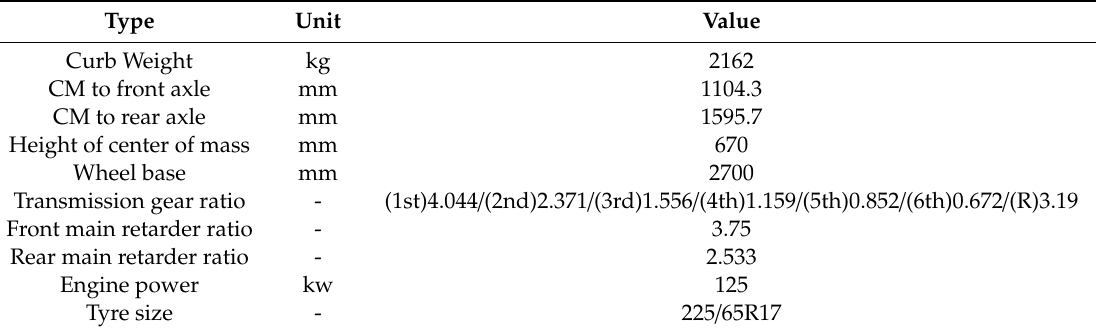
Table 1. Main parameters of the prototype